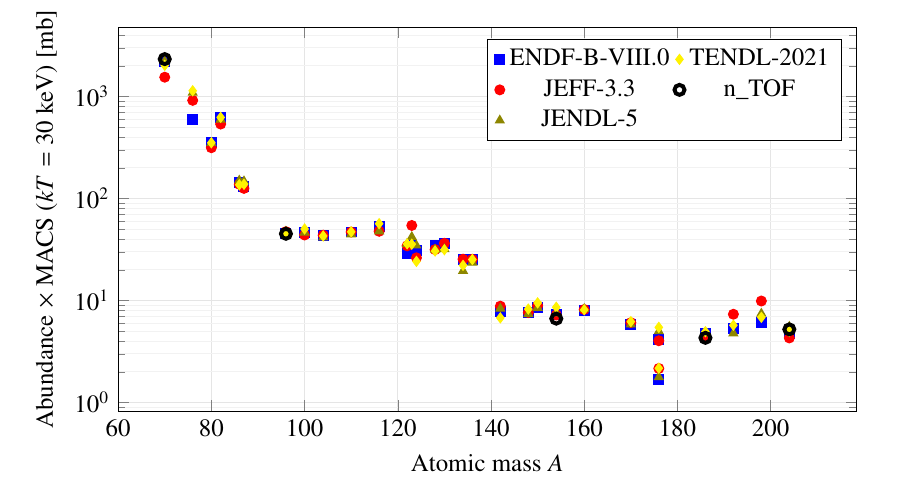
Figure 2. The product of the cross section (derived from nuclear data libraries) times the solar s- process abundances for s-only isotopes [15]. In the region between magic neutron numbers, the local equilibrium approximation is clearly visible. The four cases studied at n_TOF are also reported for comparison.